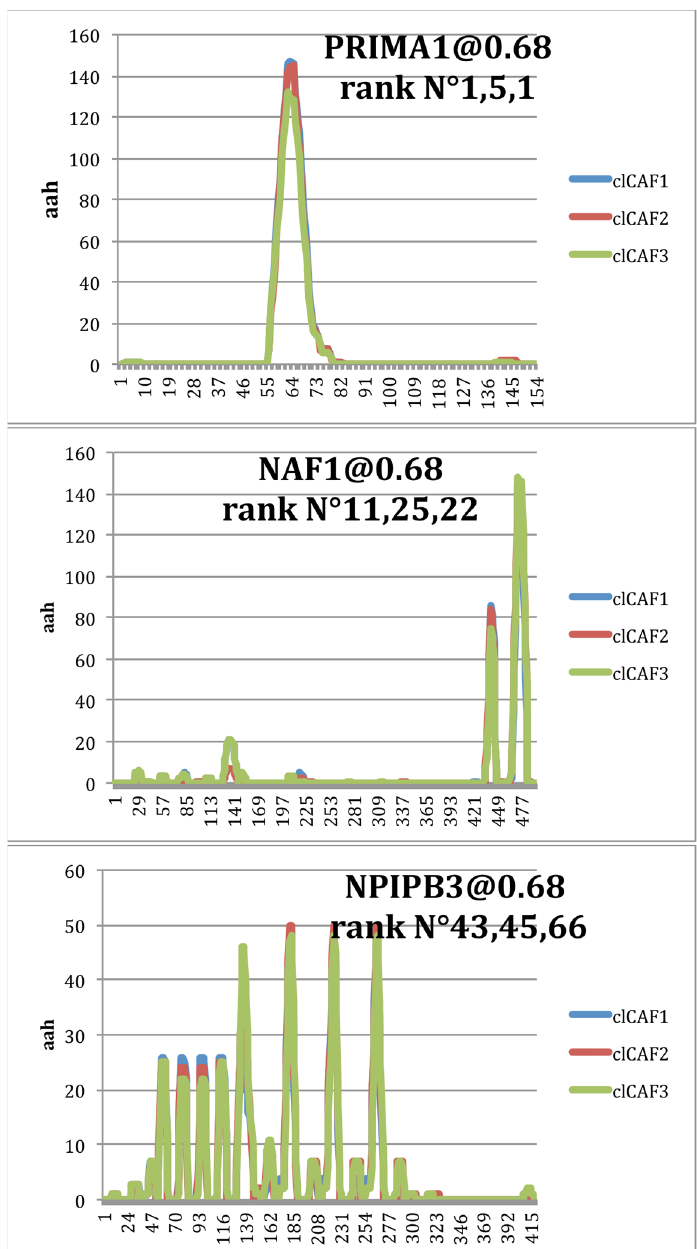
Figure 4. Mapping profiles of three CAF peptide selections on human proteins. The mapping profiles (aah) on three examples of proteins show very high similarity of the three CAF peptides selections (indicated by different colors). Score rank N° of the protein is indicated for CAF1, CAF2 and CAF3, respectively. For simplified visualization, the presented examples were chosen according to the length of proteins (<500 aa).